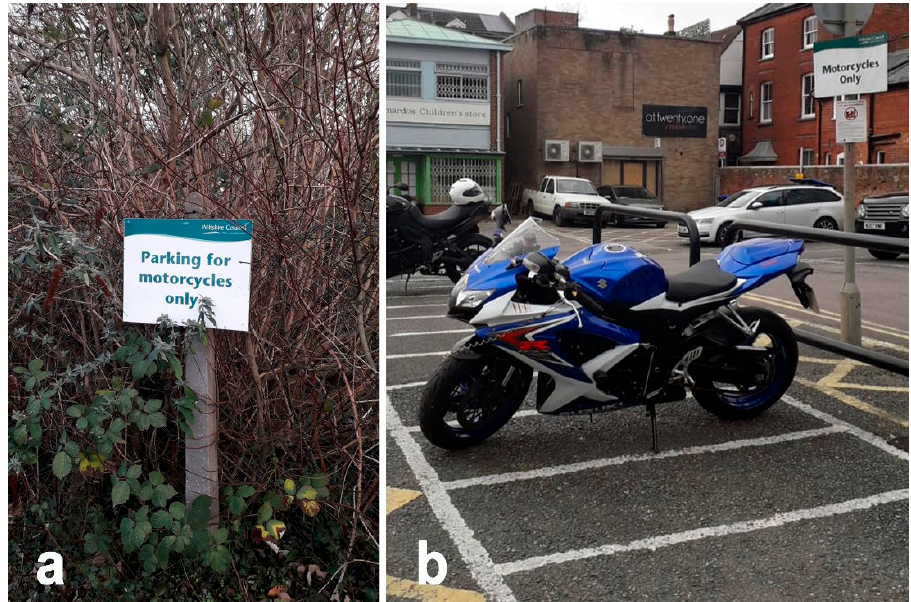
Figure 4. Great Britain: ( a ) vertical and horizontal street signage for motorcycles can be often found in the cities but also on the countryside, e.g., nearby shops; ( b ) special motorcycles’ zone in use. Source: Authors’ archives (photo E. Burdzi ń ska).